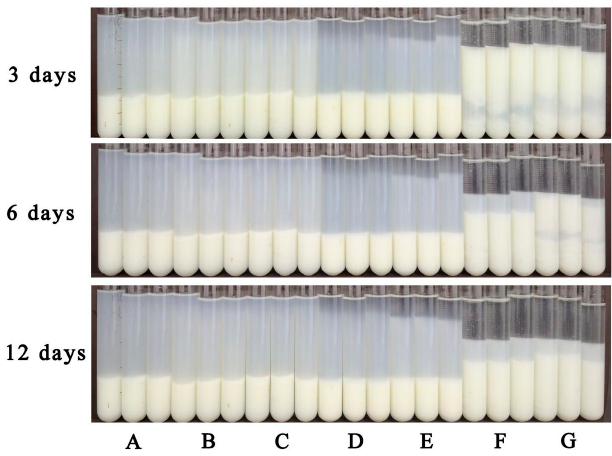
Figure 3. Macroscopic observations of NH (non-homogenized) sample and high-pressure homogenization (0–100 MPa) processed samples after 3, 6, and 12 d at 25 °C: ( A ) 100 MPa; ( B ) 80 MPa; ( C ) 60 MPa; ( D ) 40 MPa; ( E ) 20 MPa; ( F ) 0 MPa; ( G ) NH, and each capital letter (A to G) refers to a triplicate of tubes.